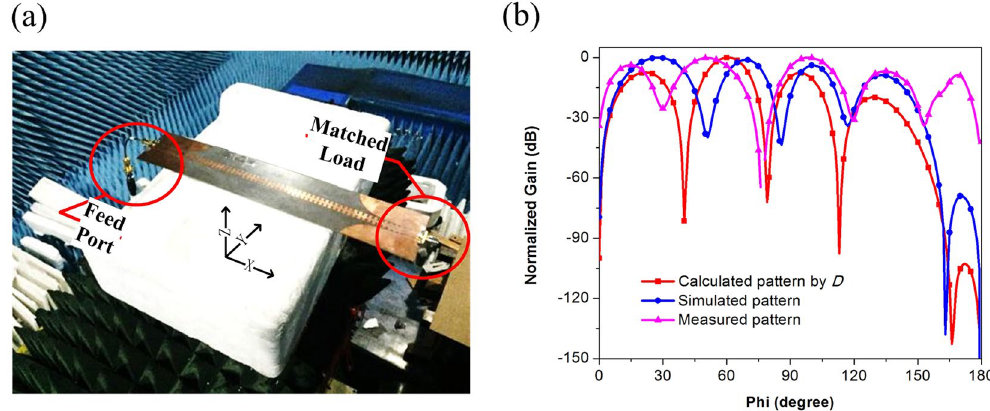
Figure 7. ( a ) Measurement environment in an anechoic chamber. ( b ) Normalized radiation patterns obtained by three different methods.